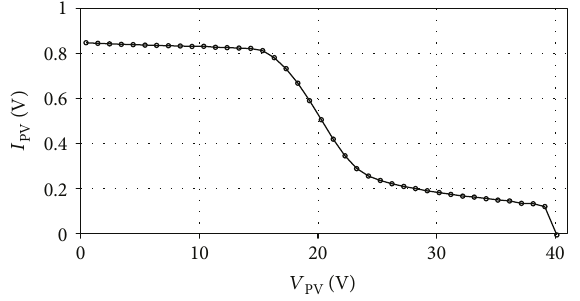
Figure 7: I - V characteristic of the two series-connected PVUs. 26 September 2017, Aversa (CE), Italy. S 1 = 616 W/m 2 characterizes the unshaded cells, and S 2 = 145W/m 2 characterizes the shaded cell; T amb = 25 ° C .